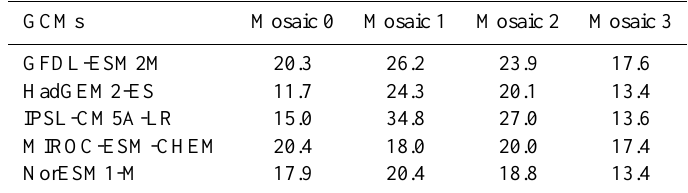
Table 3. Global average of monthly SD (%RH) in relative humidity, shown in Fig. 4, for each land use. GCMs Mosaic 0 Mosaic 1 Mosaic